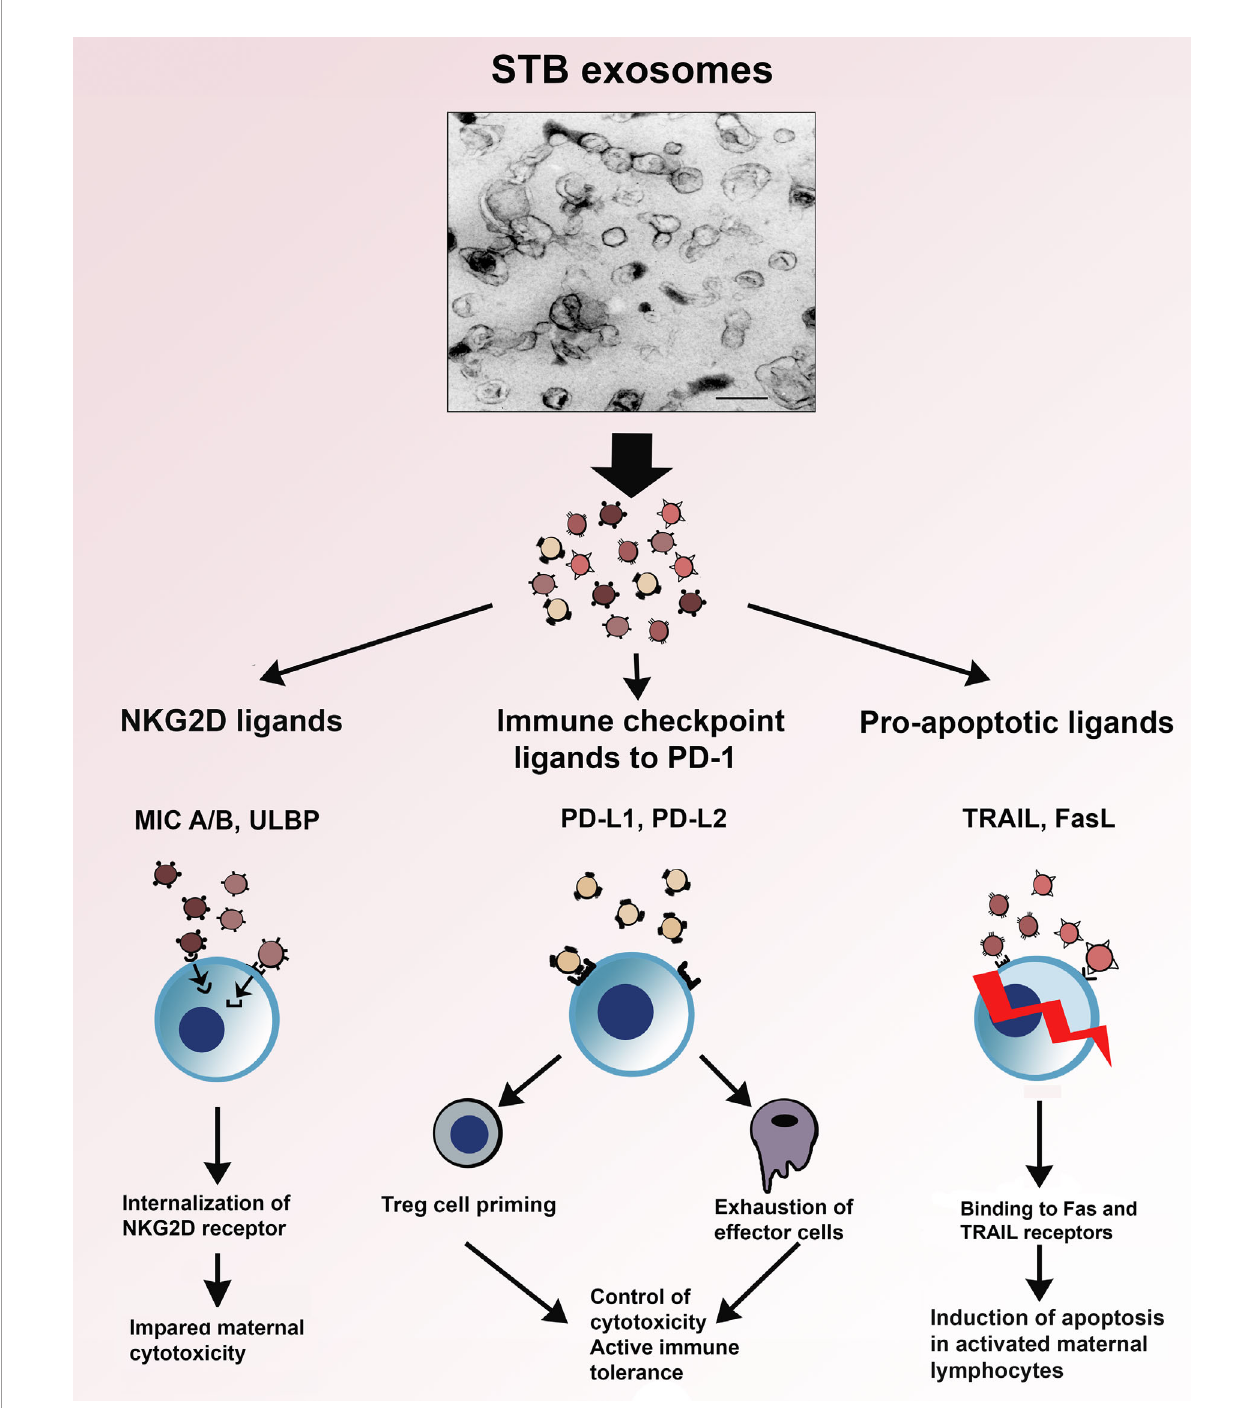
FIGURE 4 | Electron micrograph of STB exosomes isolated from supernatants of placental explant cultures and schematic presentation of their role in three immune mechanisms – NKG2D-mediated cytotoxicity, apoptosis and immune checkpoint